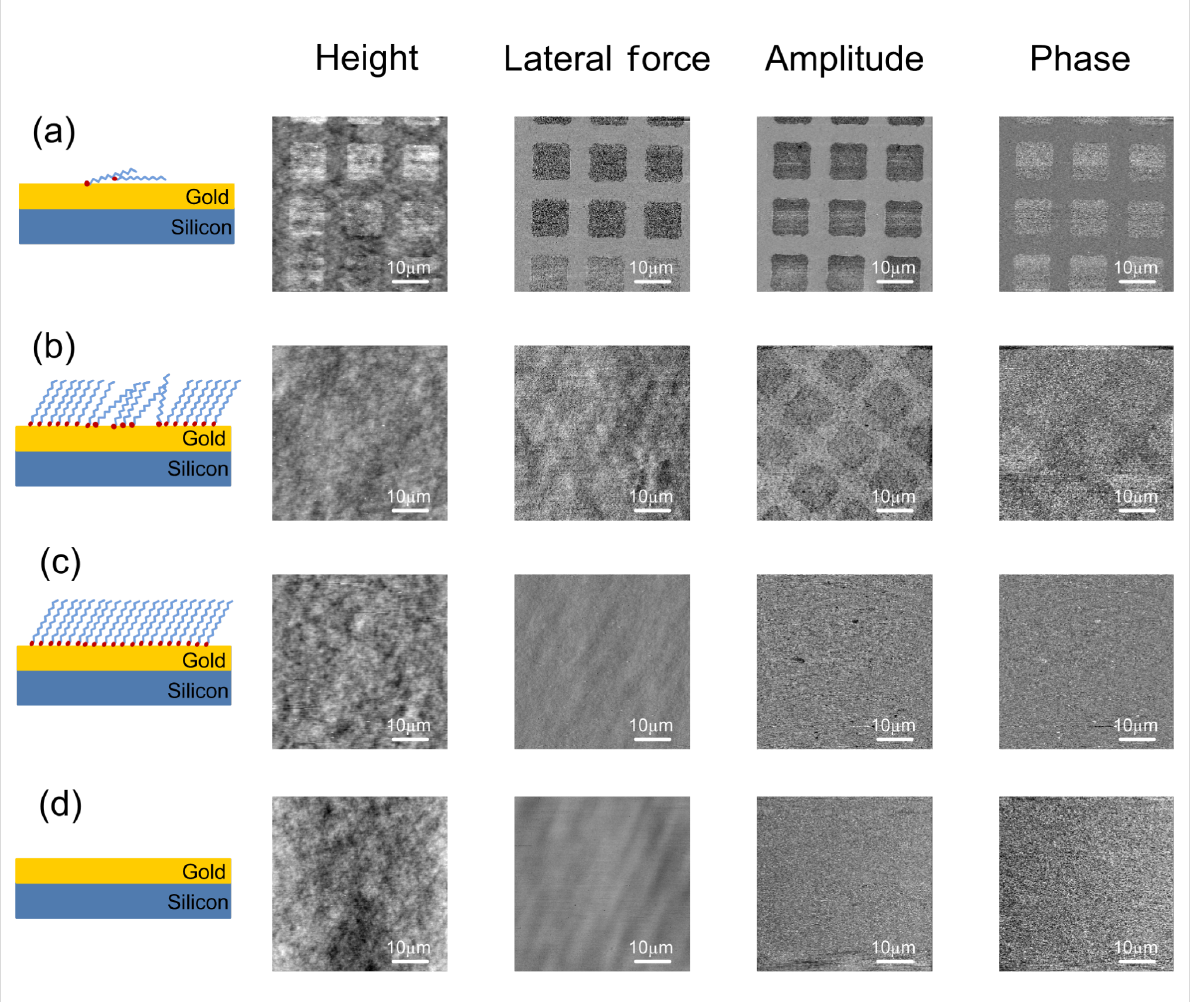
Figure 4: Schematic and FMM images of a series of EG 3 patterns on gold. Height, lateral force, amplitude, and phase images were captured simulta- neously. (a) Low-EG 3 -grafting-density areas patterned on a gold substrate. The height difference between EG 3 and gold is about 1 nm. The lateral- force image shows the chemical force difference between the areas. The contrast in the amplitude image demonstrates that the EG 3 areas are signifi- cantly softer than the gold background. (b) Low-EG 3 -grafting-density areas (squares) and high-grafting-density background. Height and lateral-force images cannot resolve differences in the morphology and chemical force, while amplitude images differentiate between high- and low-grafting-density regions (i.e., the original patterns are visible in the amplitude image). (c) Patterned surfaces imaged after overnight exposure to a thiol solution. Height, chemical-force, and stiffness images are uniform. (d) Negative control: gold surface after photolithography and resist stripping shows no surface residues.